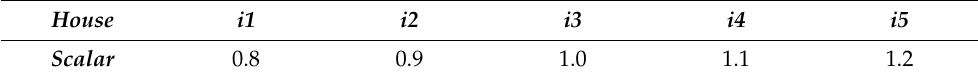
Table 4. Scalars used to obtain demand profiles for each house in the network